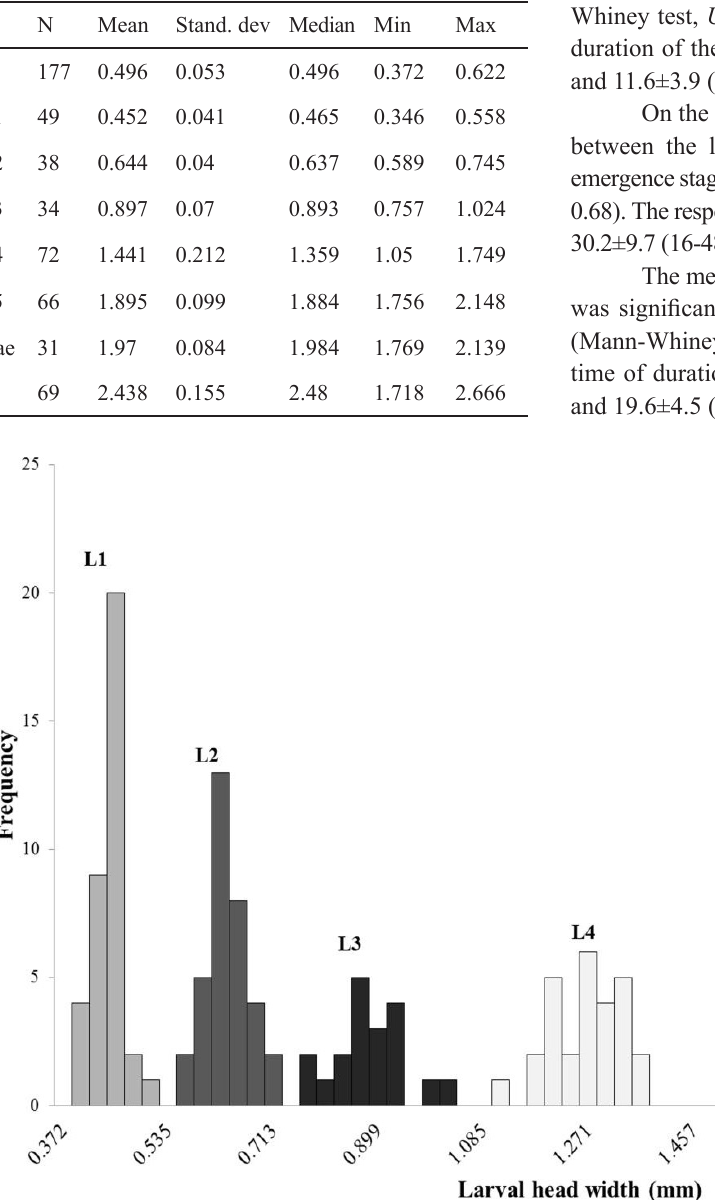
Table 1 – Descriptive statistics of the widths (mm) of the eggs and the cephalic capsules of the larvae (L1 – L5), pre-pupae (PP) and the pupae (P) of Mischocyttarus cerberus.